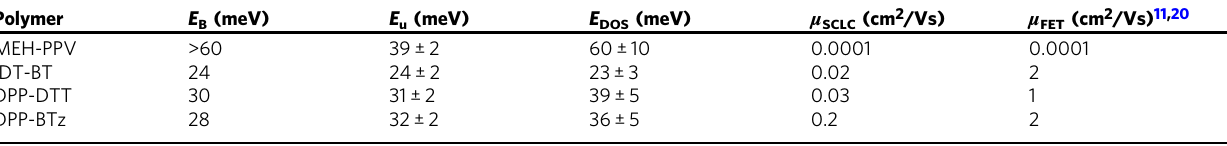
Comparisonofthewidthofthetailoftrapstatesextractedfromanalysisofthe r value( E B ),fromanexponential fi tofthed n /d E curvesfromSCLCspectroscopy( E DOS )andtheUrbachenergiesextracted from optical absorption spectroscopy ( E u ) along with a comparison of FET and SCLC mobilities measured for the polymers MEH-PPV, IDT-BT, DPP-BTz, and DPP-DTT. The given errors were estimated from the uncertainty in the extraction procedure. FET fi eld-effect transistor, MEH-PPV poly[2-methoxy-5-(2-ethylhexyloxy)-1,4-phenylenevinylene], IDT-BT indacenodithiophene- co -benzothiadiazole, DPP-BTz poly[[2,5-bis(2-octadecyl)-2,3,5,6- tetrahydro-3,6-diketopyrrolo[3,4- c ]pyrrole-1,4-diyl]-alt-(2-octylnonyl)-2,1,3-benzotriazole], DPP-DTT diketopyrrolo-pyrrole-dithiophene-thienothiophene, SCLC space charge-limited conduction, DOS density of